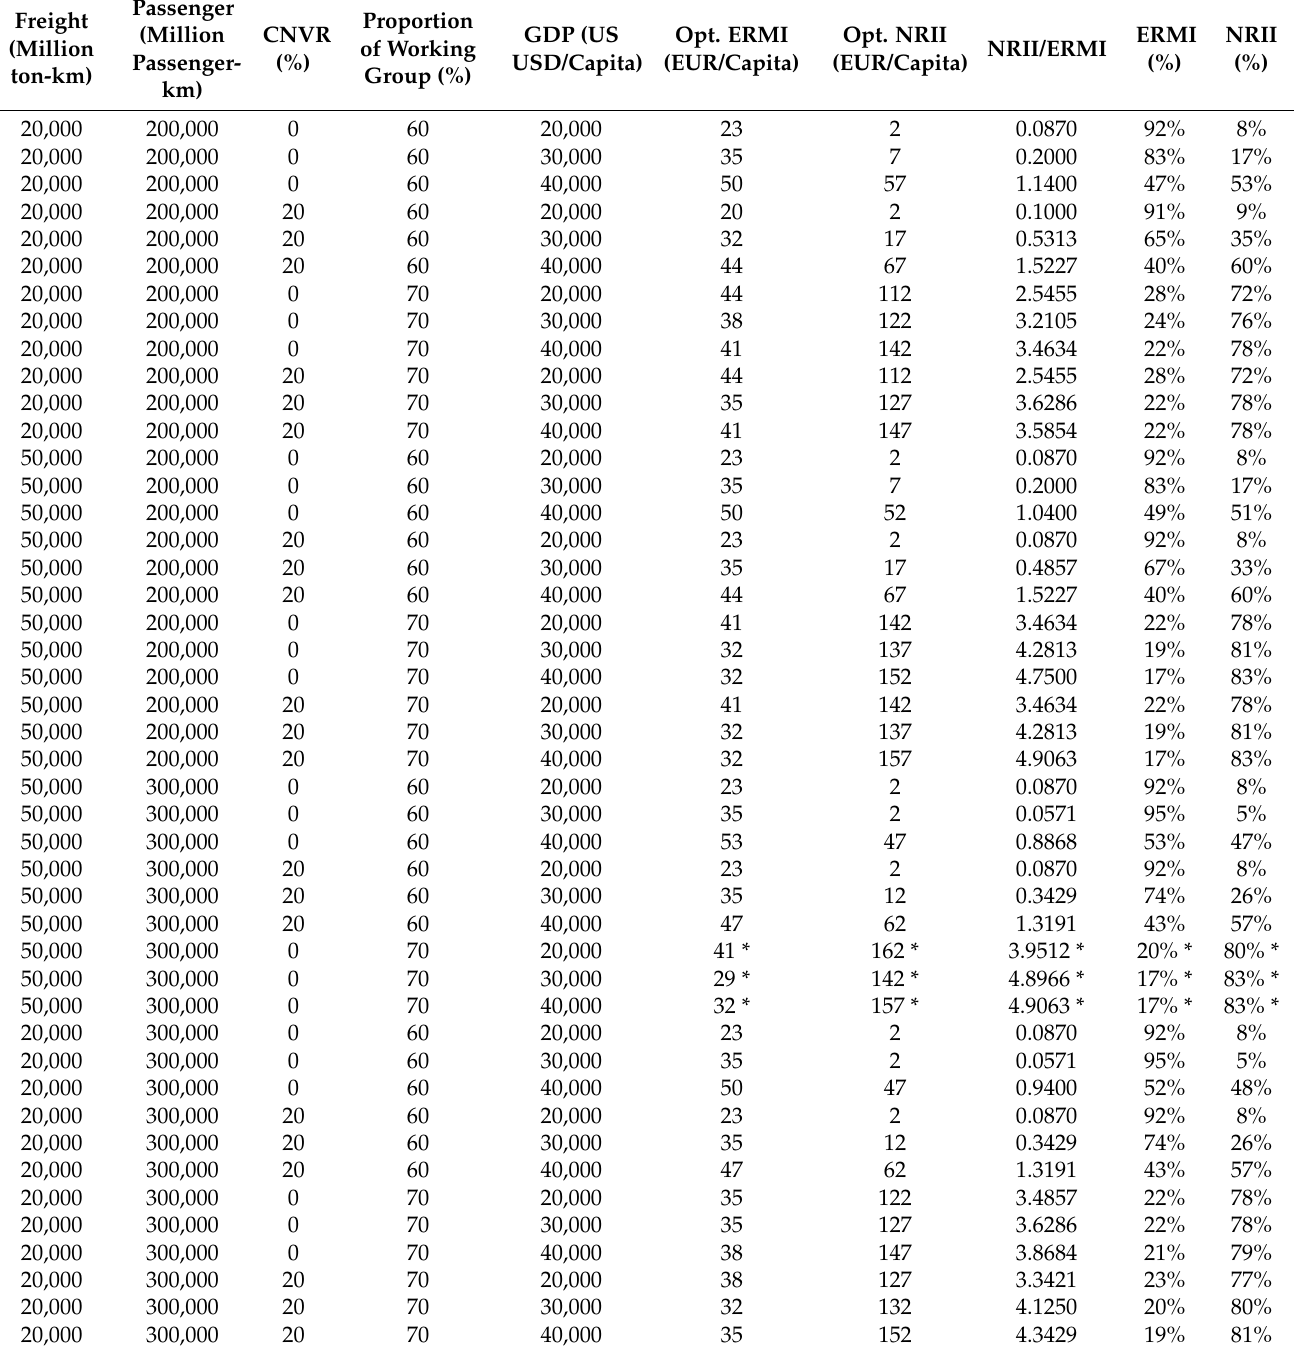
Table A2. Optimized annual ERMI and NRII per capita for population of 15